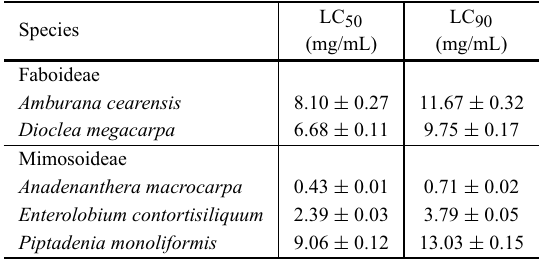
LC 50 and LC 90 of water extracts of leguminous seeds against 3 rd instars of Aedes aegypti after 24h of exposure 1 . LC Species